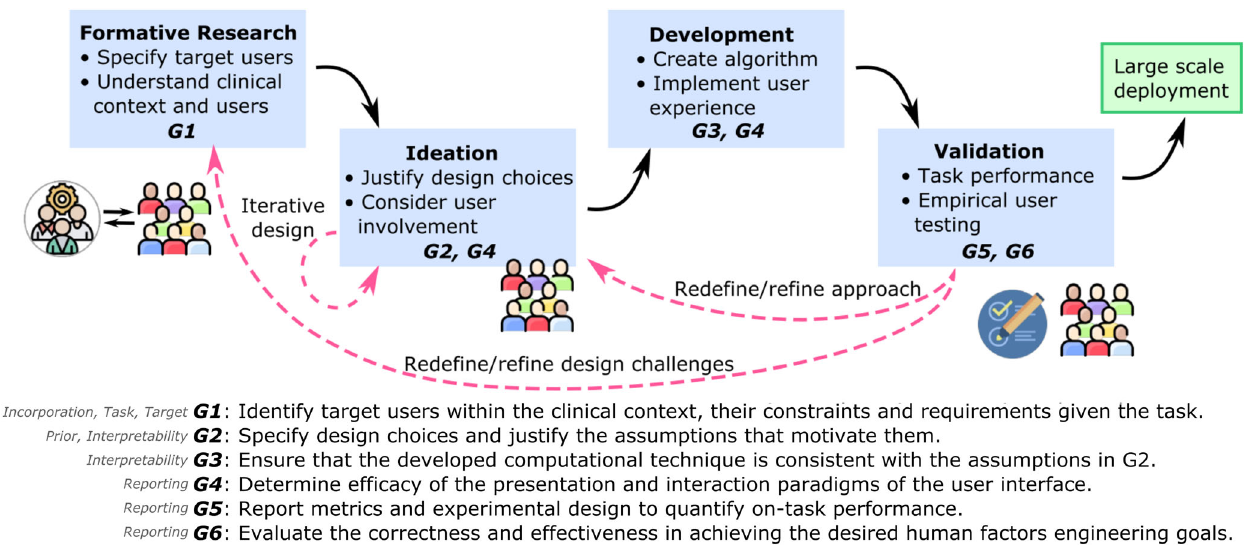
Fig. 1 Schematic representation of the INTRPRT guideline within the main stages of a human-centered design process. The blue boxes demonstrate the process from understanding end users and their context to the validation of the developed system, which ultimately might result in large scale deployment. The guidelines are summarized below and are located within the design phases based on the aspects pertinent to each one and the corresponding themes of each guideline are listed on the left. Opportunities for iterative design are illustrated with the dashed